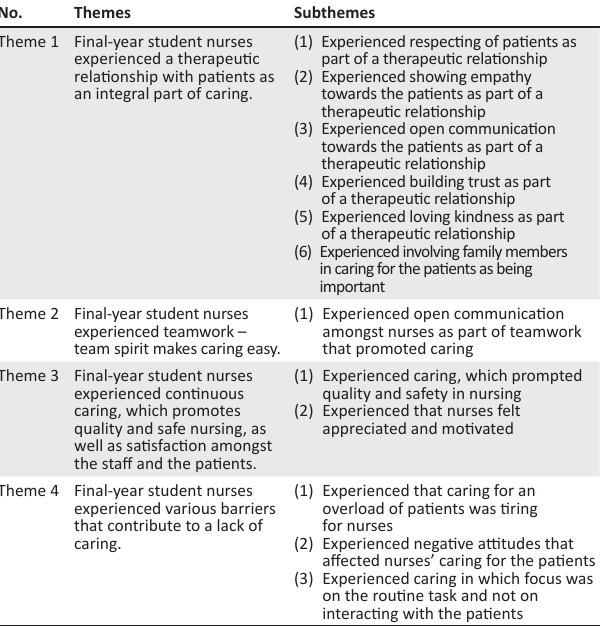
TABLE 1: Summary of themes and subthemes based on the experiences of final- year student nurses of caring for patients.